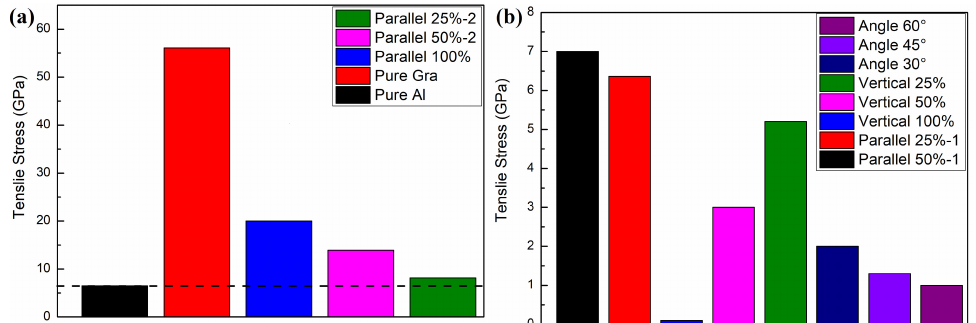
Figure 9. Mechanical properties of different forms of graphene/aluminum composites. The tensile stress of structures with different area ratios of graphene parallel to the stretching direction are shown in ( a ), and the tensile stress of structures with different graphene angles to the stretching direction are shown in ( b ).